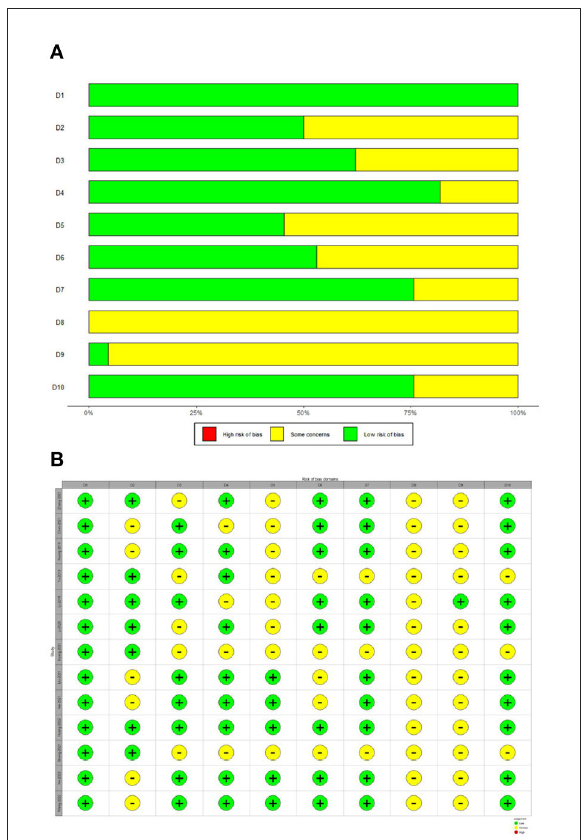
FIGURE2 Risk of bias with SYRCLE tool. (A) Risk of bias graph. (B) Risk of bias summary. D1 (Selection bias): Was the allocation sequence adequately generated and applied? D2 (Selection bias): Were the groups similar at baseline or were they adjusted for confounders in the analysis? D3 (Selection bias): Was the allocation adequately concealed? D4 (Performance bias): Were the animals randomly housed during the experiment? D5 (Performance bias): Were the caregivers and/or investigators blinded from knowledge which intervention each animal received during the experiment? D6 (Detection bias): Were animals selected at random for outcome assessment? D7 (Detection bias): Was the outcome assessor blinded? D8 (Attrition bias): Were incomplete outcome data adequately addressed? D9 (Reporting bias): Are reports of the study free of selective outcome reporting?